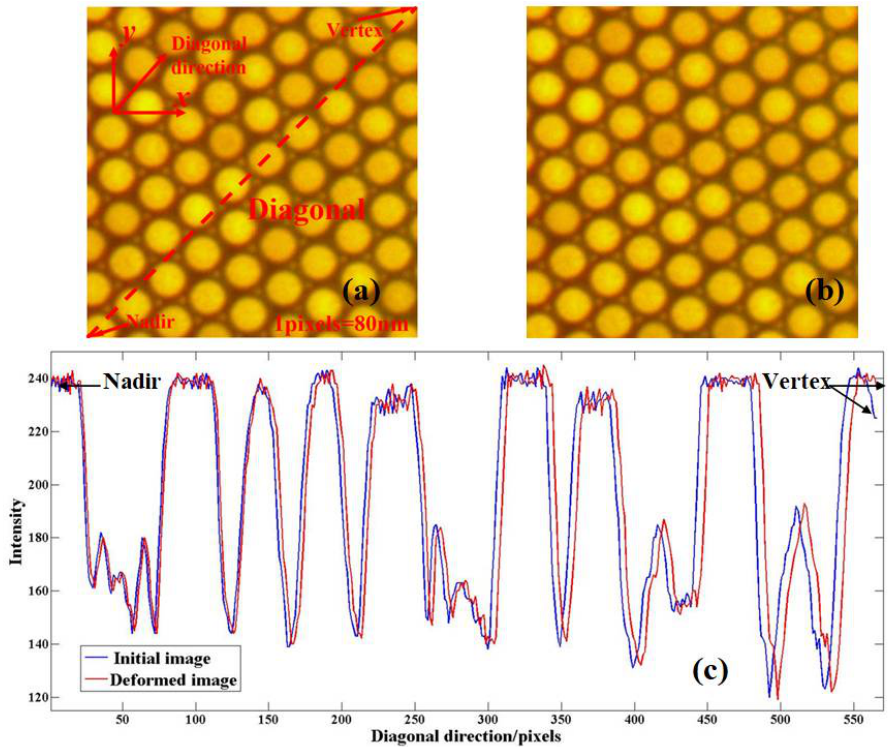
Figure 9. Experimental images captured by microscope: ( a ) original image; ( b ) deformed image; ( c ) intensity data of ( a , b ) in diagonal direction.